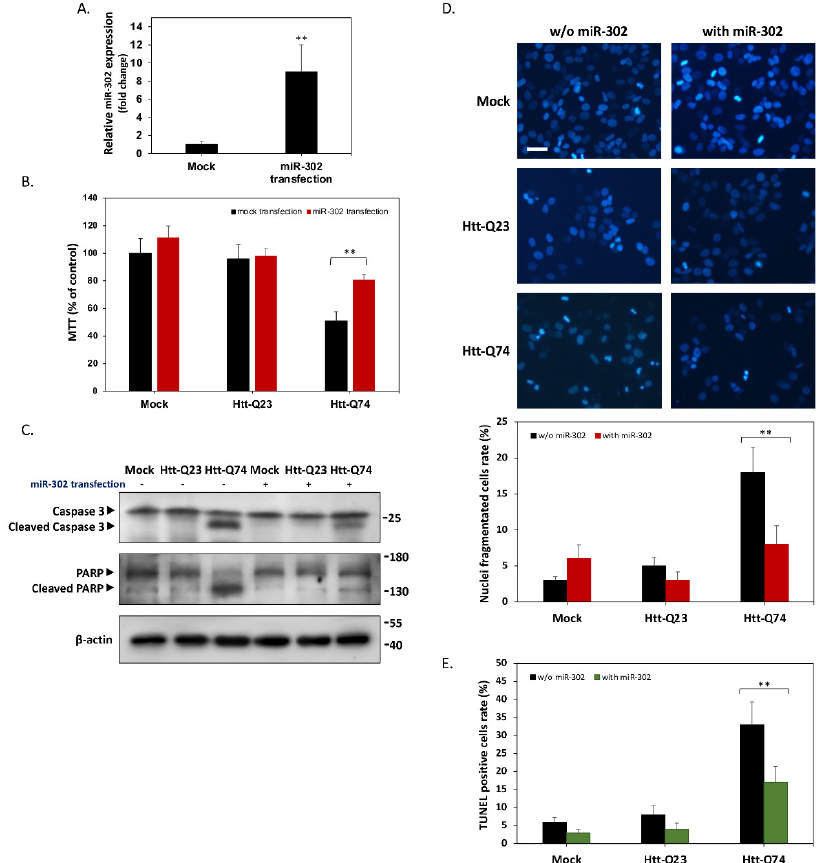
Figure 2. Upregulation of miR-302 cluster protects neuronal cells from Htt-Q74-induced apoptosis. ( A ) SK-N-MC neu- ronal cells are transfected with miR-302 overexpressing vector for 48 h. The qPCR results indicate the successful miR-302 overexpression in transfected cells. ( B ) Cell viability is measured by MTT assay 48 h post-transfection. The result indicates that overexpression of miR-302 cluster significantly improves cell viability in mHtt-Q74-overexpressed cells. ( C ) Western blot analysis demonstrates that upregulation of miR-302 cluster inhibits cleavage of caspase 3 and PARP, two apoptotic markers involved in mHtt-induced neurotoxicity. ( D ) Nuclear fragmentation examined by DAPI cytochemistry staining. mHtt-Q74-induced apoptotic nuclear fragmentation is markedly decreased by co-transfection of miR-302. ( E ) Cell are stained with the terminal deoxynucleotide transferase dUTP nick-end labeling (TUNEL) method, and apoptotic cells are counted. All values are presented as mean ± SEM. Significant difference was determined by using the multiple compar- isons of Dunnett’s posthoc test for ** p < 0.01. Scale bar represents 20 μ m. 2.3. Upregulation of miR-302 Cluster Facilitates Mitochondrial Autophagy in mHtt-Overexpressing Cells A significant decline in autophagy activity has been described in HD cells [11]. Therefore, we next investigated whether miR-302 affects the activity of autophagy in mHtt-transfected neuronal cells. The results of acridine orange (AO) staining were shown in Figure 3A, demonstrating that compared to the mock group, mHtt-Q74 transfection significantly decreased the average number of acidic vesicular organelles (AVOs) per cell from 9.5 ± 2.3 to 1.0 ± 1.2. However, co-transfection with miR-302 cluster effectively re-